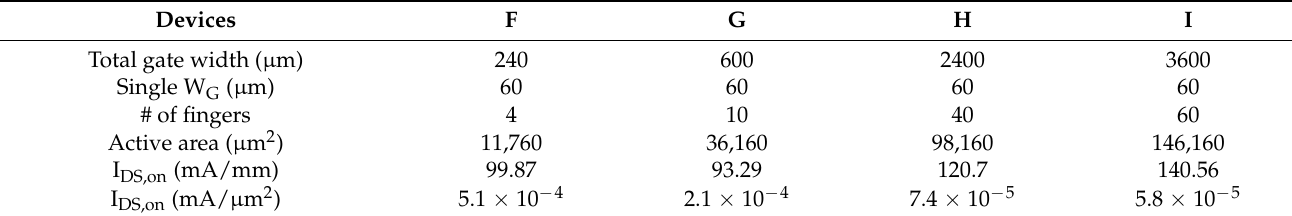
Table 2. Design parameters for W G = 60 µ m devices with different number of fingers.